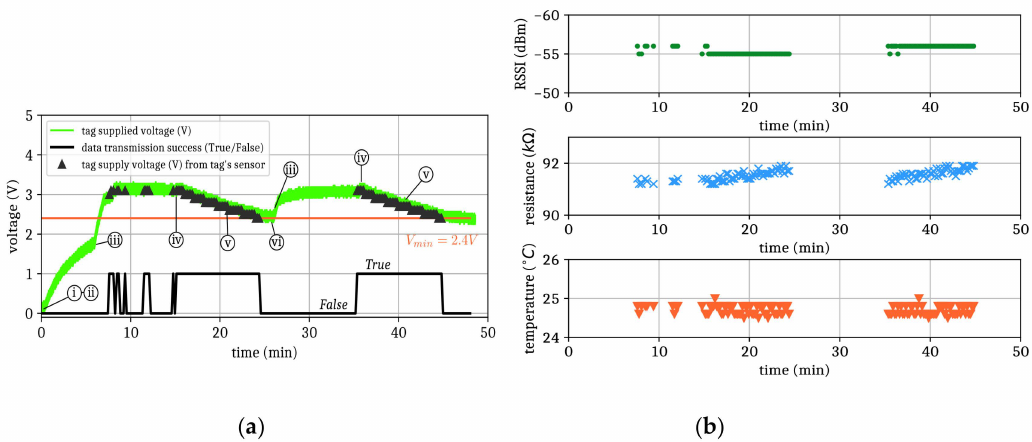
Figure 5. ( a ) Voltage at the port of the supercapacitor measured with oscilloscope (green curve) with RF power density of 12.6 µ W / cm 2 ; ( b ) Received signal strength indicator (RSSI) (green dots), resistance of the photoresistor (blue crosses), and temperature (orange downward-pointing triangles) are displayed only when the sensor data were successfully